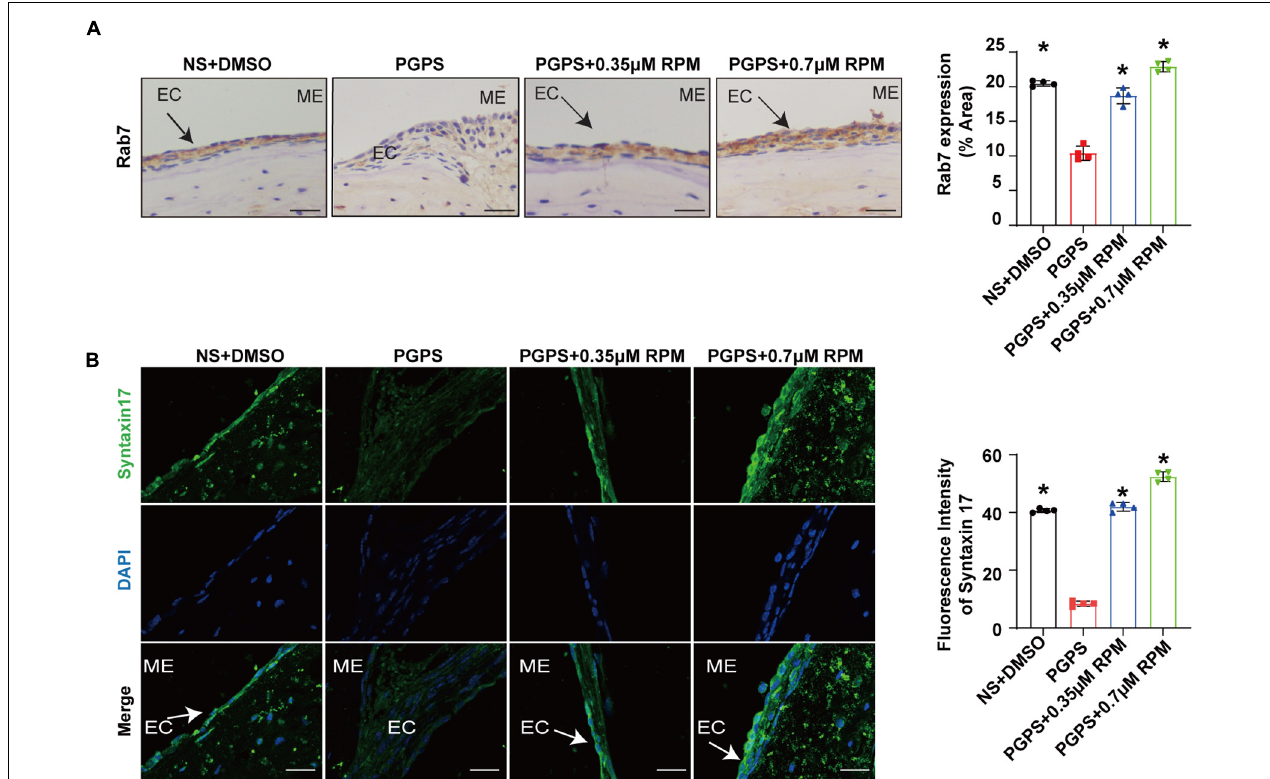
FIGURE 8 | Rapamycin treatment increases the fusion of autophagosomes and lysosomes in OM mice. Mice were inoculated with PGPS or a combination of PGPS and either 0.35 or 0.7 µ M RPM. Paraffin-embedded sections of ME tissues were immunostained antibodies. (A) The representative images and quantification of Rab7 expression in ME tissues. (B) The representative images and quantification of Syntaxin 17 expression in ME tissues. n = 4 per group, ME represents the middle ear; EC represents epithelial cells. * P < 0.05 vs. the PGPS group, one-way ANOVA, Scale bar = 25 µ m.